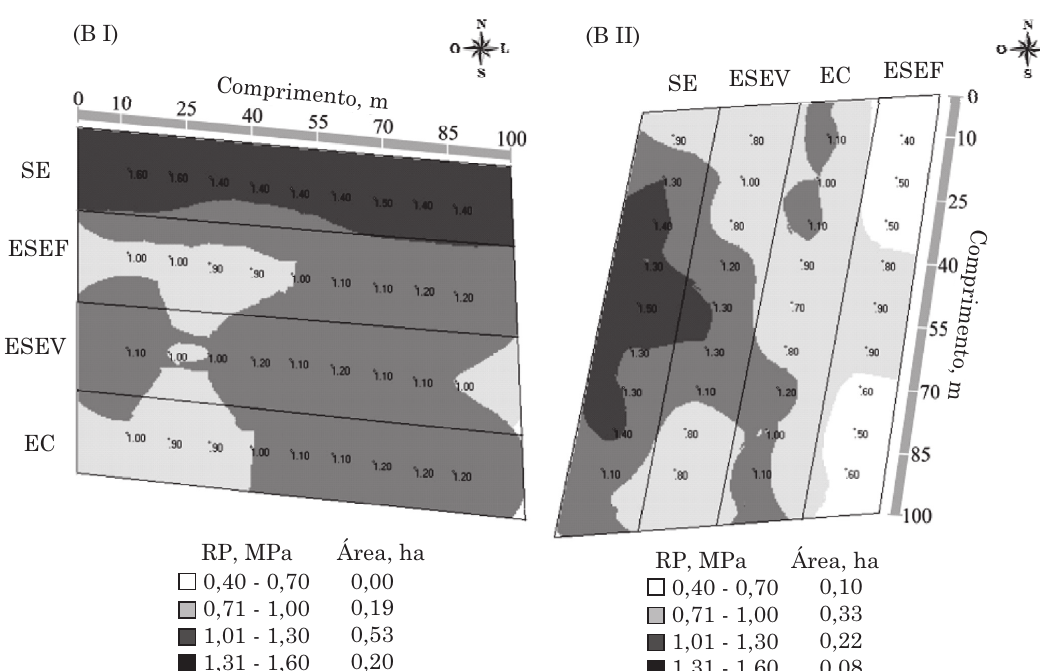
Figura 5. Variabilidade espacial da resistência à penetração do solo, determinada logo após a escarificação mecânica, nos dois blocos em que, (B I) = bloco I e (B II) bloco II. RP: resistência à penetração; EC: escarificador convencional; ESEV: escarificador sítio-específico com profundidade de atuação variável; ESEF: escarificador sítio-específico com profundidade de atuação fixa; e SE: sem escarificação